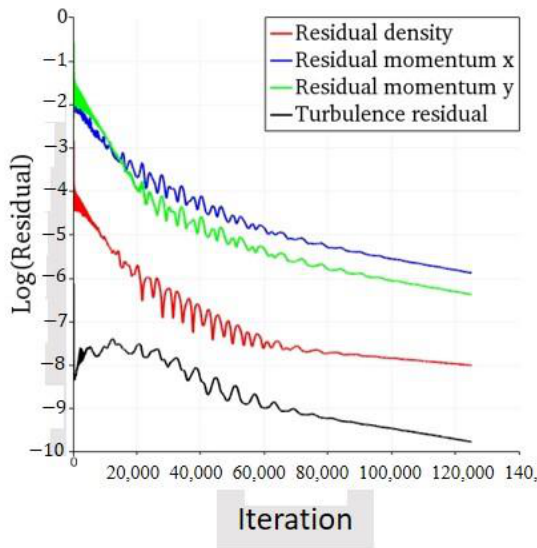
Figure 3. Iterative convergence of the baseline simulation.